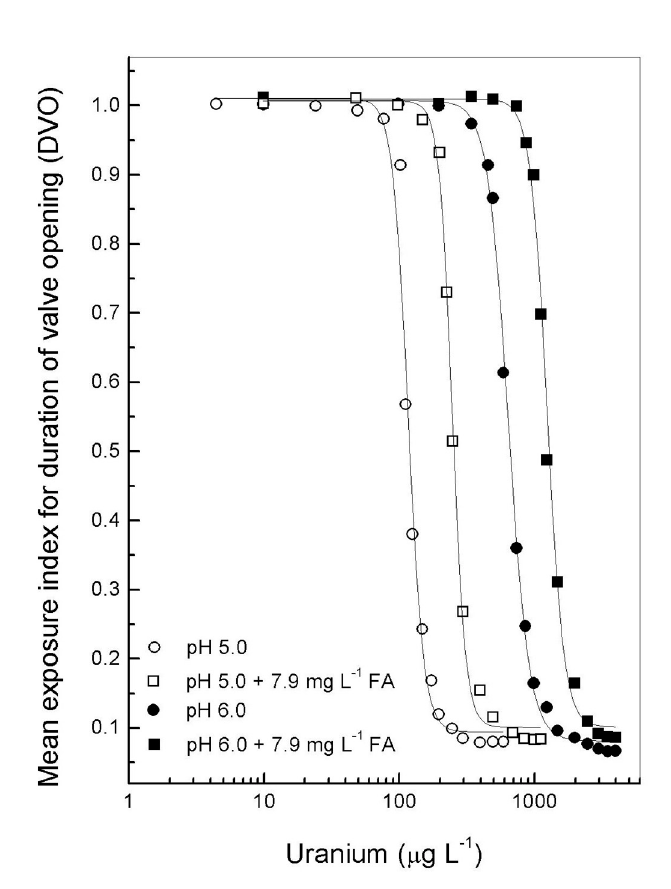
FIGURE 3. Concentration-response relationships of the duration of valve opening (DVO) for V. angasi exposed to U in synthetic Magela Creek water at pH 5 and 6 with and without model FA (7.9 mg l -1 ). Each plotted point represents the mean response of six bivalves. Error bars are excluded for